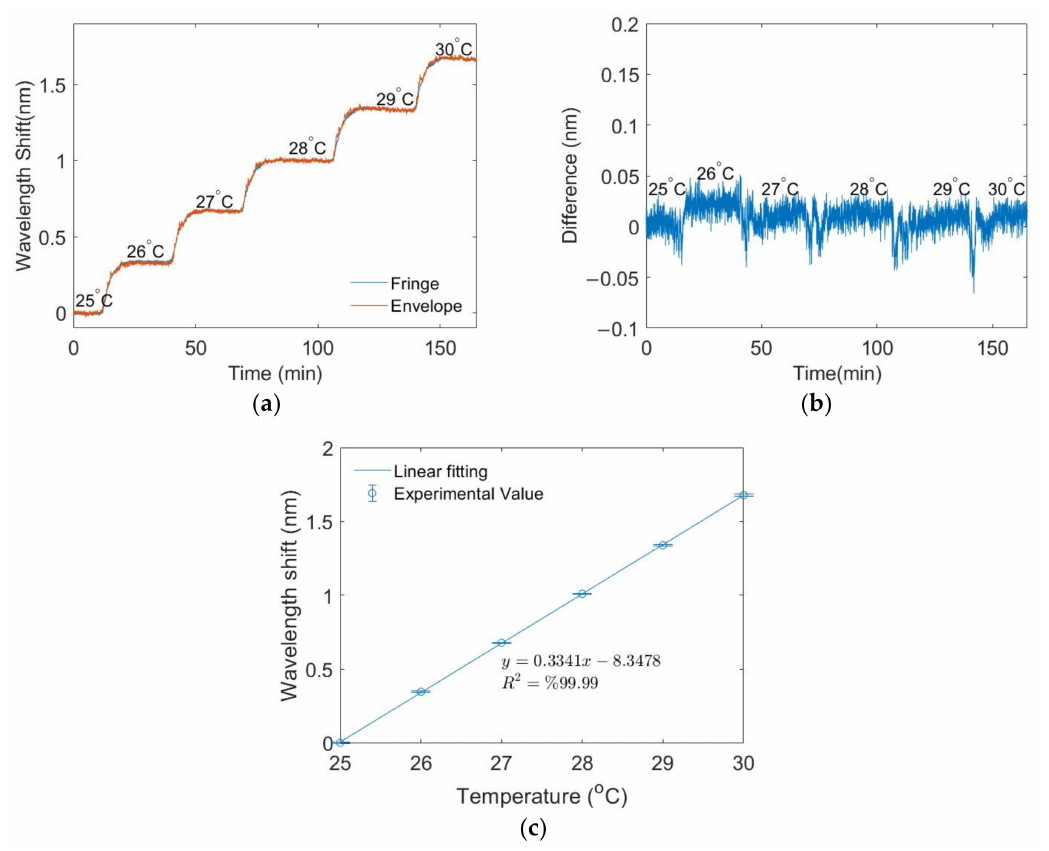
Figure 6. Temperature measurements results: ( a ) wavelength shifts of fringe and envelope; ( b ) differ- ence between the wavelength shifts of fringes and envelope; ( c ) calibration curve of the envelope’s wavelength